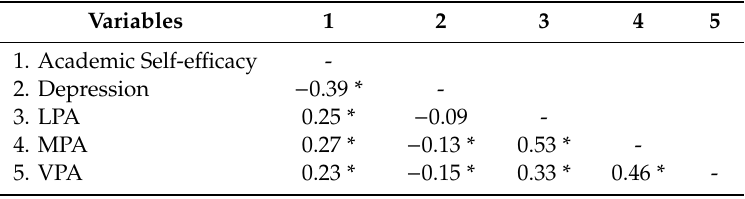
Table 2. Correlations among study variables.